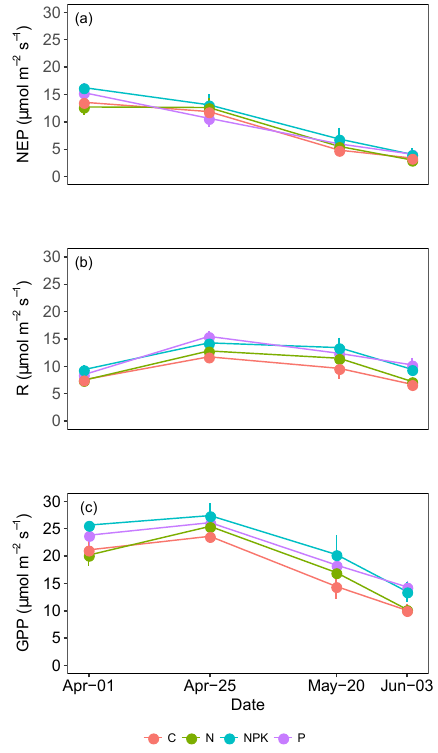
Figure 3. Average net ecosystem productivity (NEP) (a) , dark res- piration ( R ) (b) and gross primary productivity (GPP) (c) measured in grasslands under different fertilization regimes (C, N, NPK and P). Each point is the average of 6 replicates. Vertical bars represent standard errors.